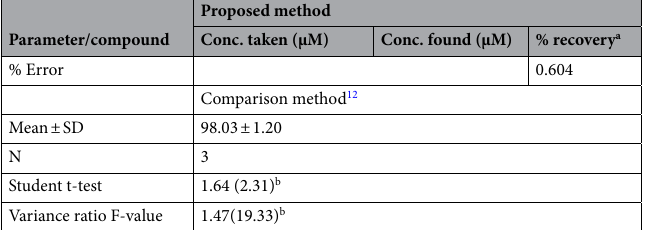
Table 3. Application of the proposed method for the determination of RFP, TNZ, ONZ, and MNZ in raw materials. a Mean of three determinations. b Values in parenthesis are the tabulated t- and F- values at p = 0.05 64